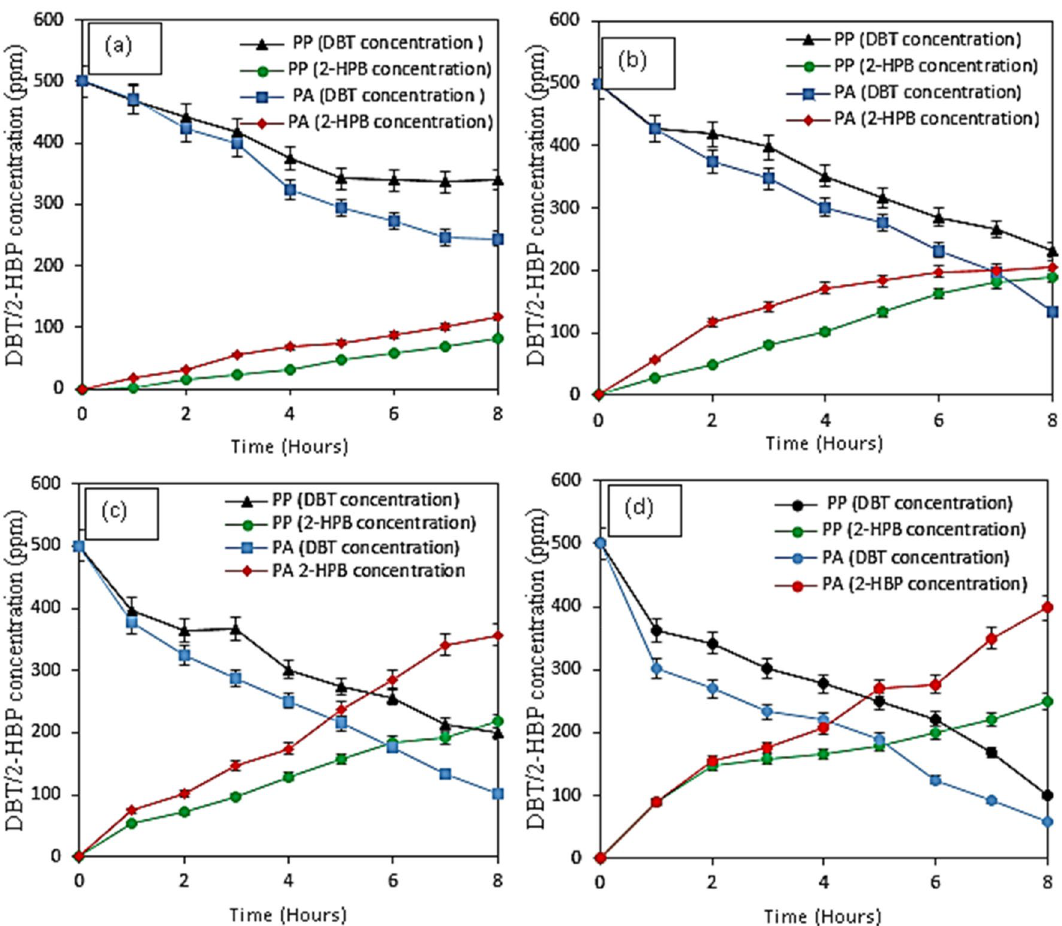
Figure 4. Effect of cell concentration of resting cells of Pseudomonas putida and Pseudomonas aeruginosa on the DBT degradation and production of 2-HBP ( a ) 0.3 g DCW/L ( b ) 0.6 DCW/L ( c ) 0.9 g DCW/L ( d ) 1.2 g